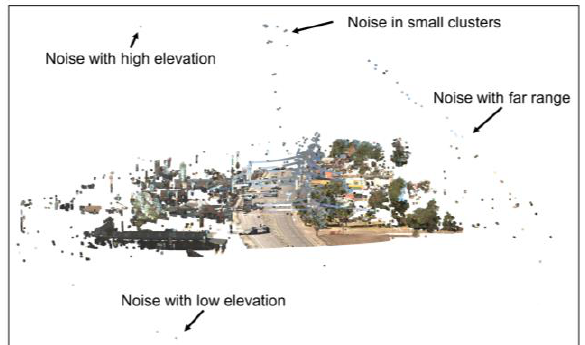
Figure 1 . Example of noise points in a mobile lidar point cloud.